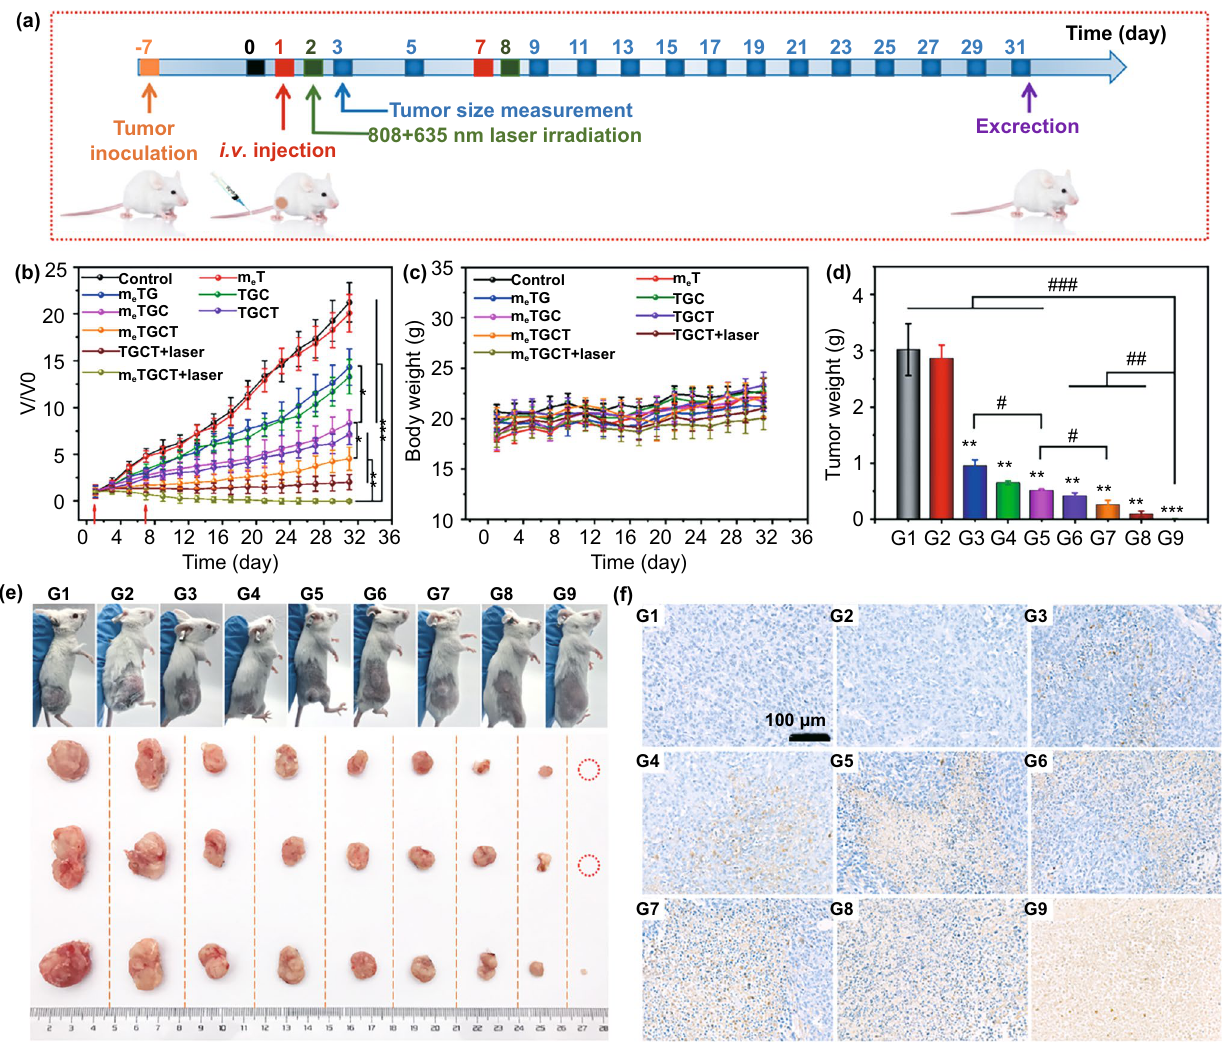
Fig. 7 a Therapy process of m e TGCT. b The variation in V/V0 in different groups. c Variations in body weight and d tumor weight during various treatments. e Photographs of mice and tumor tissues on day 31. f TUNEL staining of tumors were harvested from the mice of different treatments. (G1) Control, (G2) m e T, (G3) m e TG, (G4) TGC, (G5) m e TGC, (G6) TGCT, (G7) m e TGCT, (G8) TGCT+laser, (G9) m e TGCT+laser ( ***p < 0.001, **p < 0.01 and *p < 0.05 as contrast with Control group, ### p < 0.001, ## p < 0.01, # p < 0.05, n =